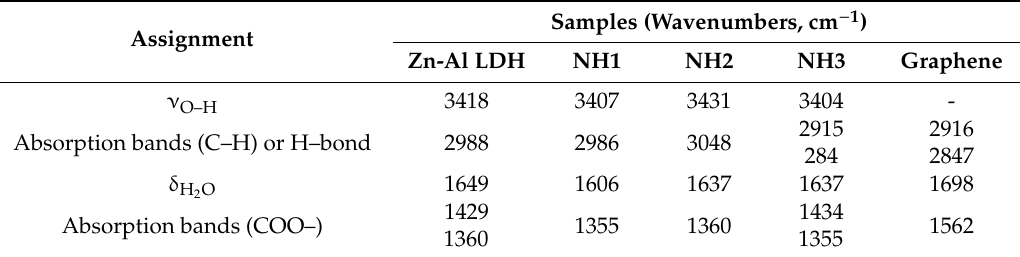
Table 1. Infrared spectra results of the prepared materials.